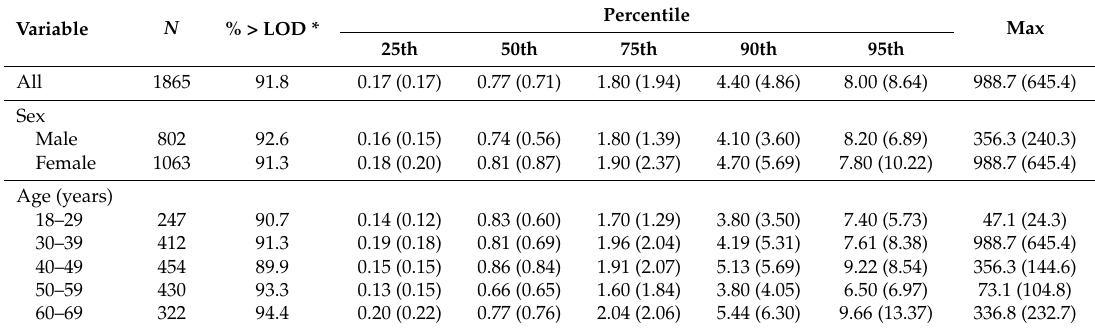
Table 3. Selected urine concentration percentiles of 4-t-octylphenol in the Korean population aged 18–69 years, by sex and age subgroups.